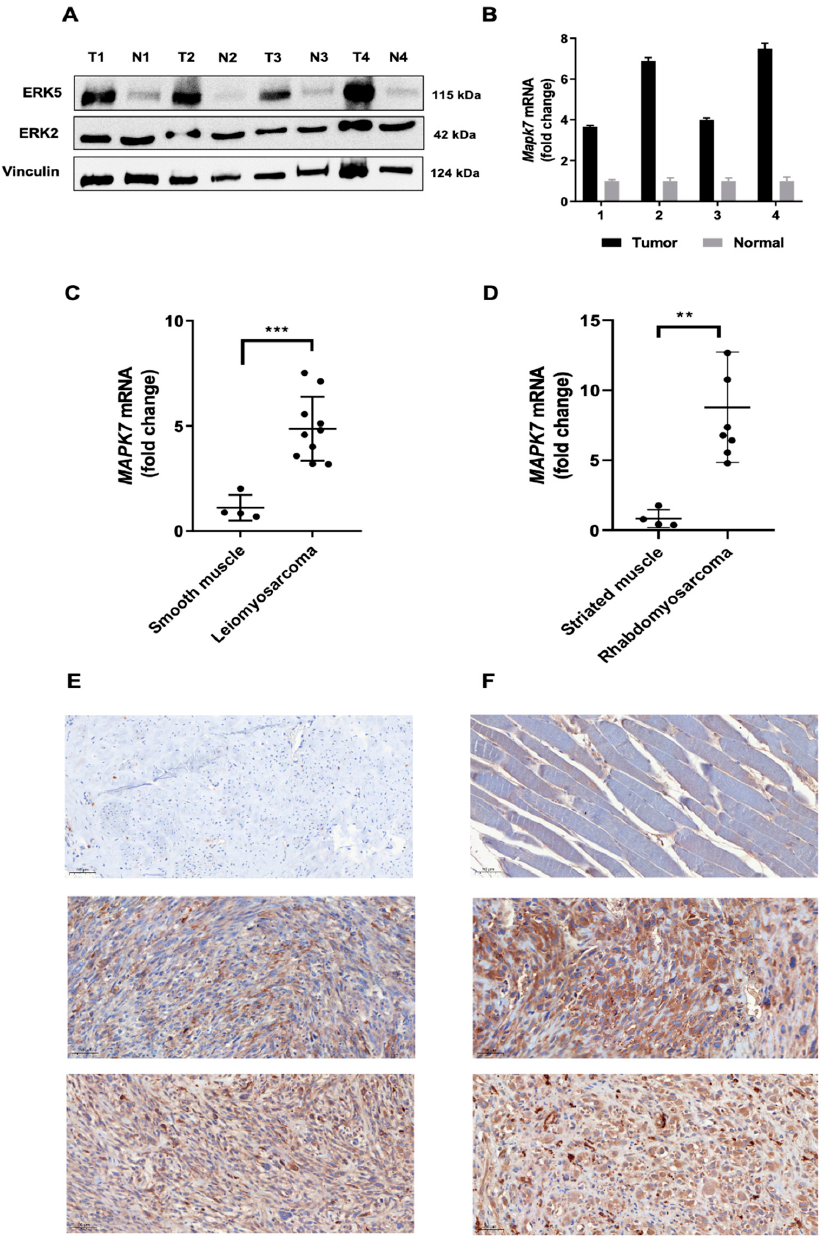
Figure 2. ERK5 levels are increased in 3MC-derived tumors and in human leiomyosarcomas and rhabdomyosarcomas. ( A ) Lysates from tumors (T) induced by 3MC and from control (N) normal muscles (n = 4) were collected, and protein extracts (100 µg) were blotted against ERK5 and ERK2 MAPKs. Vinculin was used as a loading control. ( B ) RT-qPCR analysis of Mapk7 mRNA in the same four murine tumors induced by 3MC and control normal muscles. The mRNA expression of Mapk1 (ERK2) was used as an endogenous control. ( C ) RT-qPCR analysis of MAPK7 mRNA in human leiomyosarcomas and healthy smooth muscle samples. GAPDH was used as an endogenous control. ( D ) RT-qPCR analysis of MAPK7 mRNA in human rhabdomyosarcomas and healthy striated mus- cle samples, with GAPDH as an endogenous control. ( E ) Representative images of immunohisto- chemical ERK5 staining in fixed sections of one control smooth muscle and two human leiomyosar- comas. ( F ) Representative images of immunohistochemical ERK5 staining in fixed sections of one